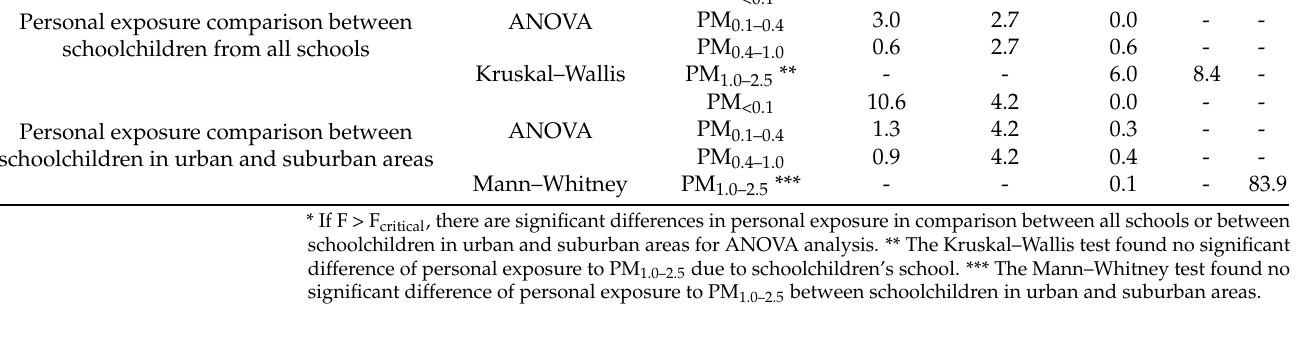
Table 5. Results of a post hoc test for the personal exposure of schoolchildren participants to PM